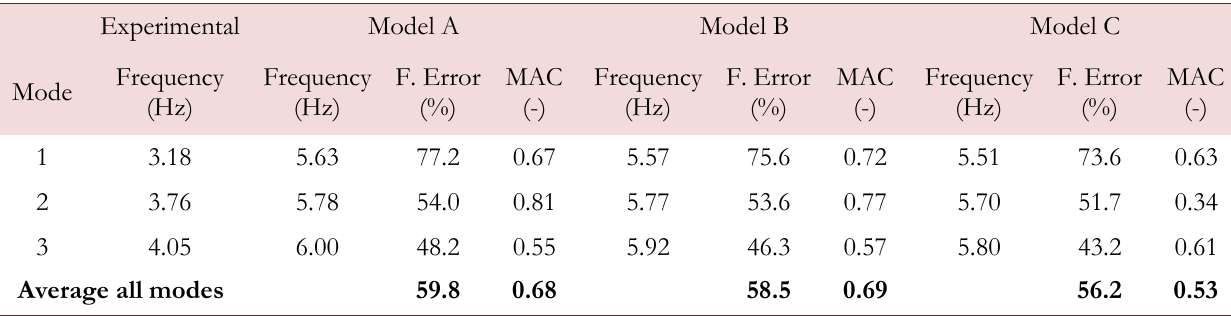
Table 5: Comparison between the frequencies and mode shapes obtained numerically (for models A, B and C) and